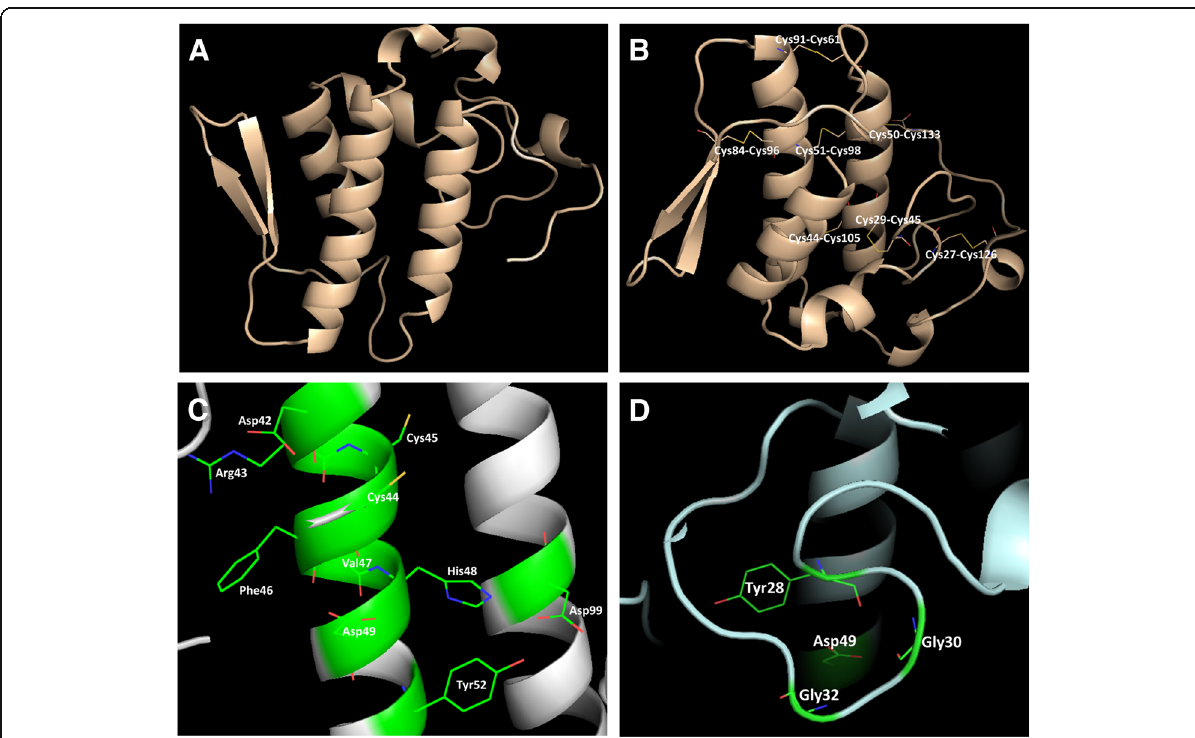
Fig. 4 Molecular modeling of BJ-PLA 2 -I. The theoretical structural model of BJ-PLA 2 -I ( a ) was generated by the program MODELLER, using the crystal structure of BthA-I-PLA 2 from B. jararacussu venom (PDB id: 1ZLB) [18] as model. Highlighted are the seven intrachain disulfide bridges formed ( b ), the amino acid residues from the conserved catalytic site ( c ) and the Ca 2+ binding loop ( d )